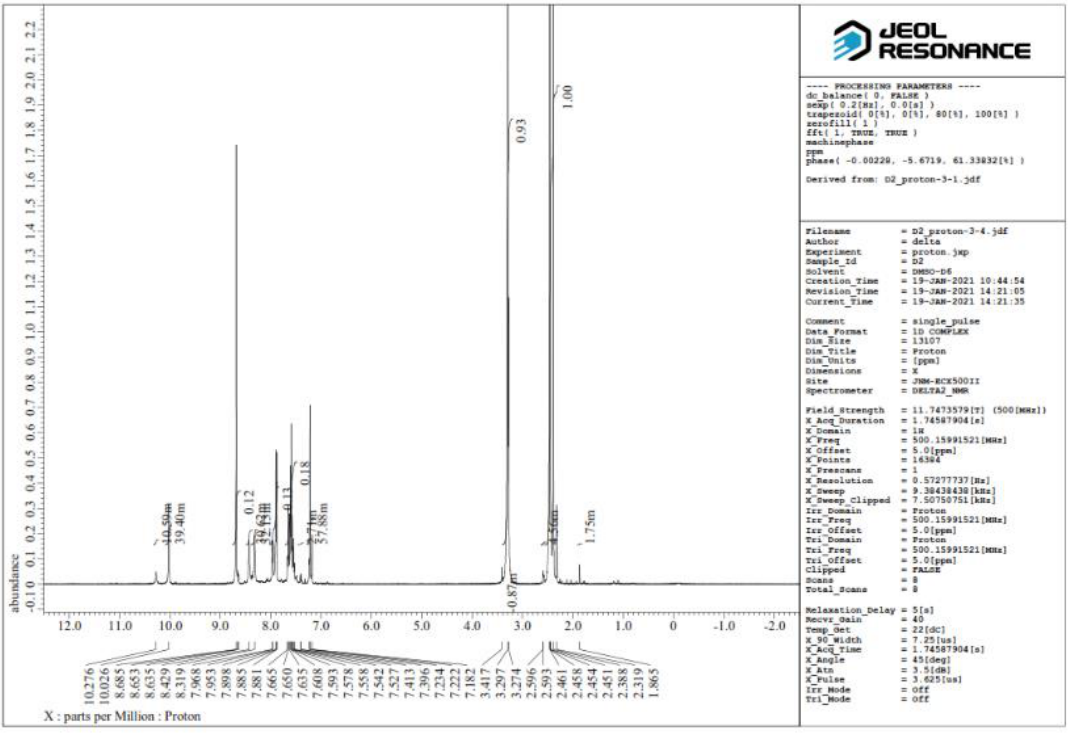
Figure 2. 1 H-NMR of compound 4.